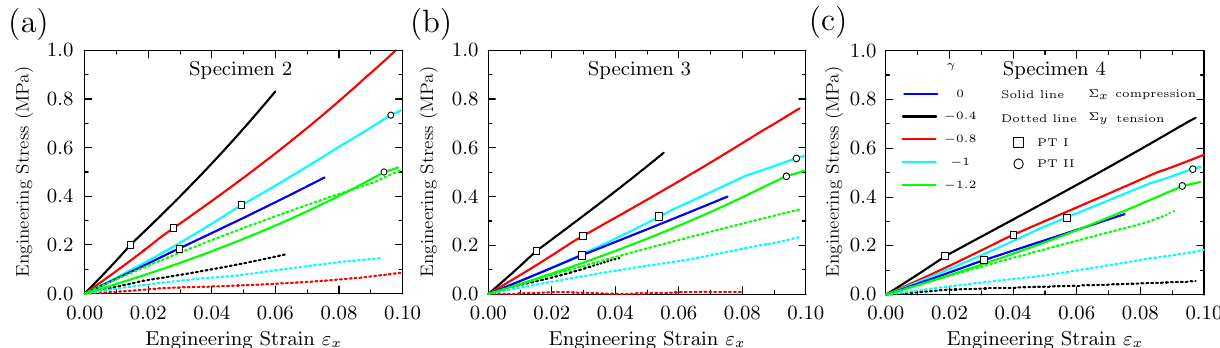
Figure 10. The engineering stress–strain responses for ( a ) specimen 2, ( b ) specimen 3 and ( c ) specimen 4 calculated at different biaxiality ratios. The critical strains of PT I and PT II are marked by unfilled squares and circles on these curves. The solid lines and the dotted lines stand for the engineering stress Σ x in the direction of x and Σ y in the direction of y ,